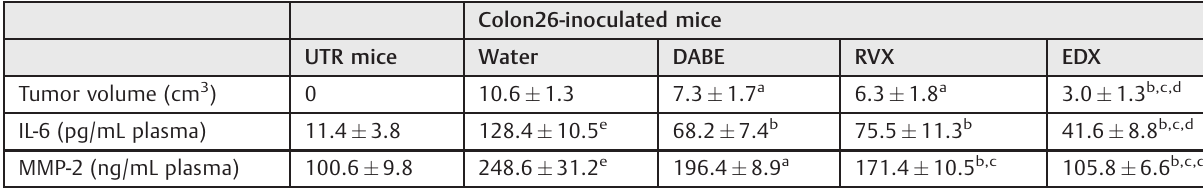
Table 2 Tumor volume and plasma levels of IL-6 and MMP-2 in untreated (UTR) mice and Colon26-inoculated mice orally treated with water or direct oral anticoagulant (DOAC) daily for 21